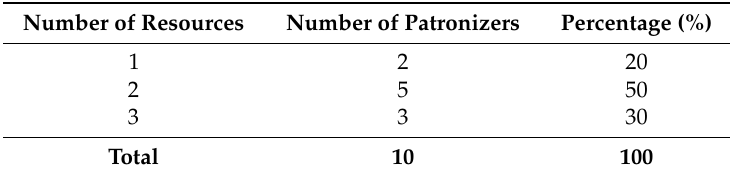
Table 4. The pattern of healthcare